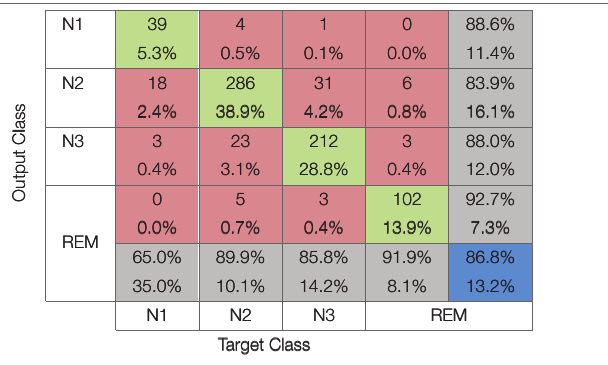
achieved maximum accuracy with synchronization likelihood